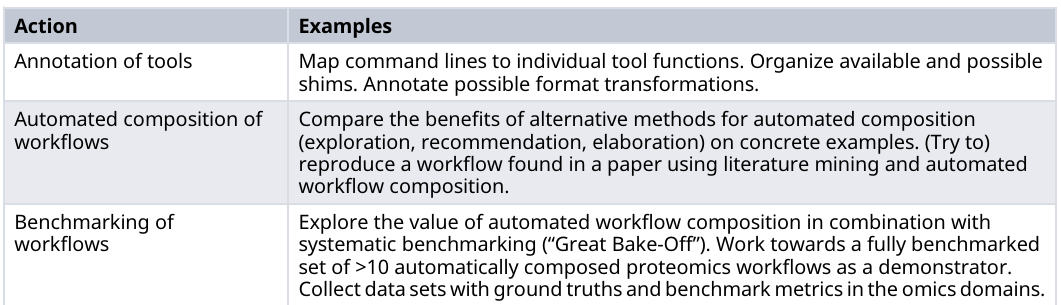
Table 5. Future work on